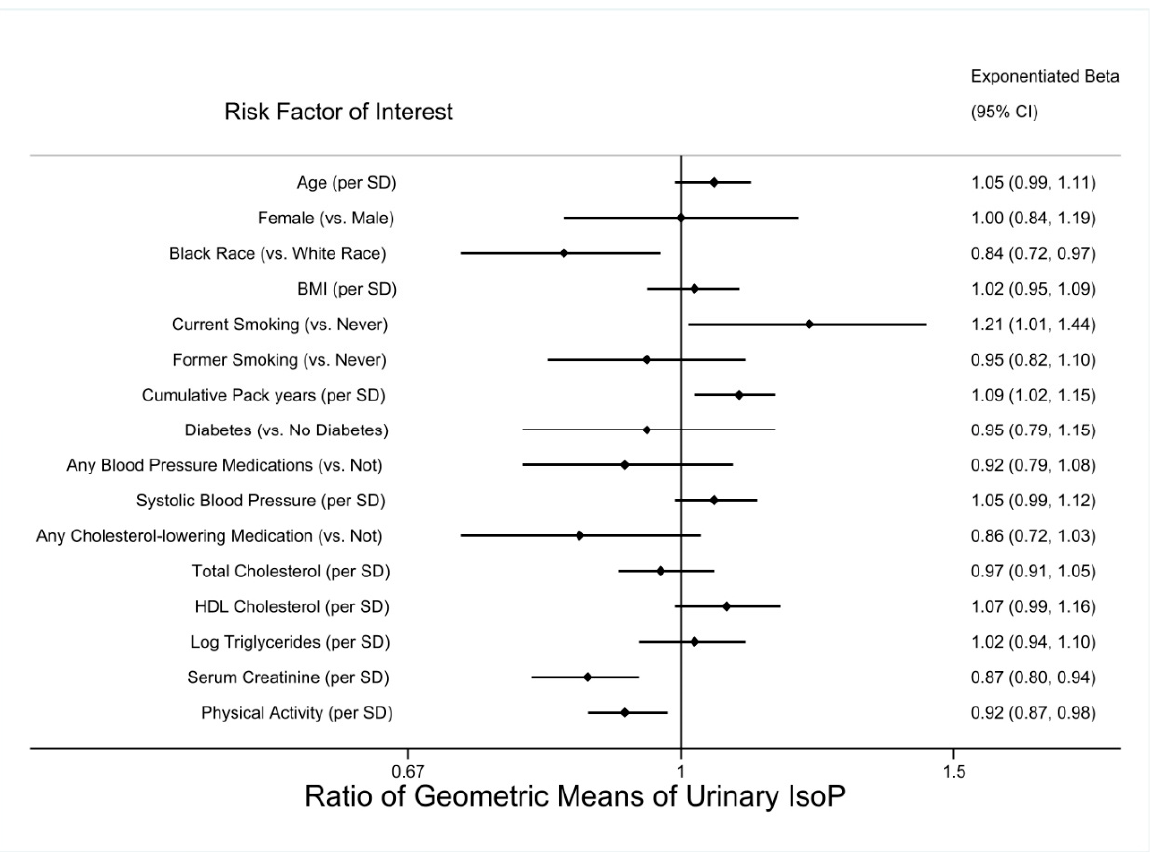
Figure 2. Adjusted associations between IsoP vs. cardiovascular risk factors. Exponentiated beta- coefficients are plotted and are equivalent to geometric ratios of analyte of interest. Ratios > 1 represent positive correlation and ratios < 1 represent inverse correlation. All CVD risk factors are mutually adjusted for one another (age, sex, race, BMI, smoking status, cumulative pack years, dia- betes, hypertension medication, systolic blood pressure, lipid-lowering medication, total cholesterol, HDL cholesterol, fasting triglyceride concentrations [log transformed], physical activity) as well as for college attainment and study center. Smoking status and cumulative pack years were highly correlated and thus were not mutually adjusted when one was considered an independent variable of